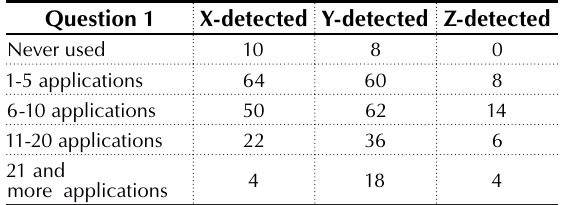
Table 4. ANOVA test results